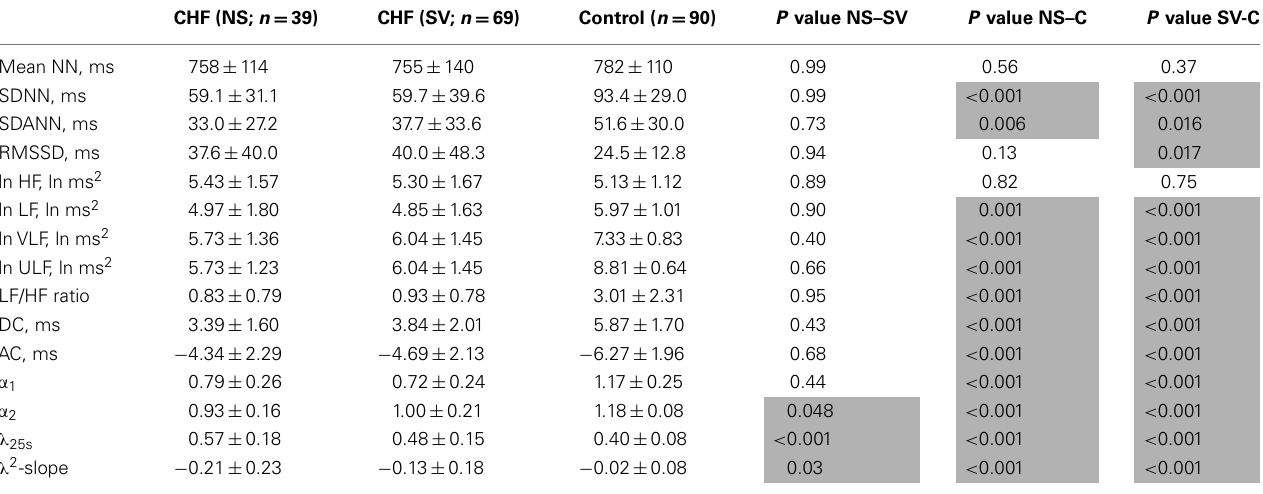
Table 5 | Heart rate variability indices in patients with congestive heart failure and age-matched